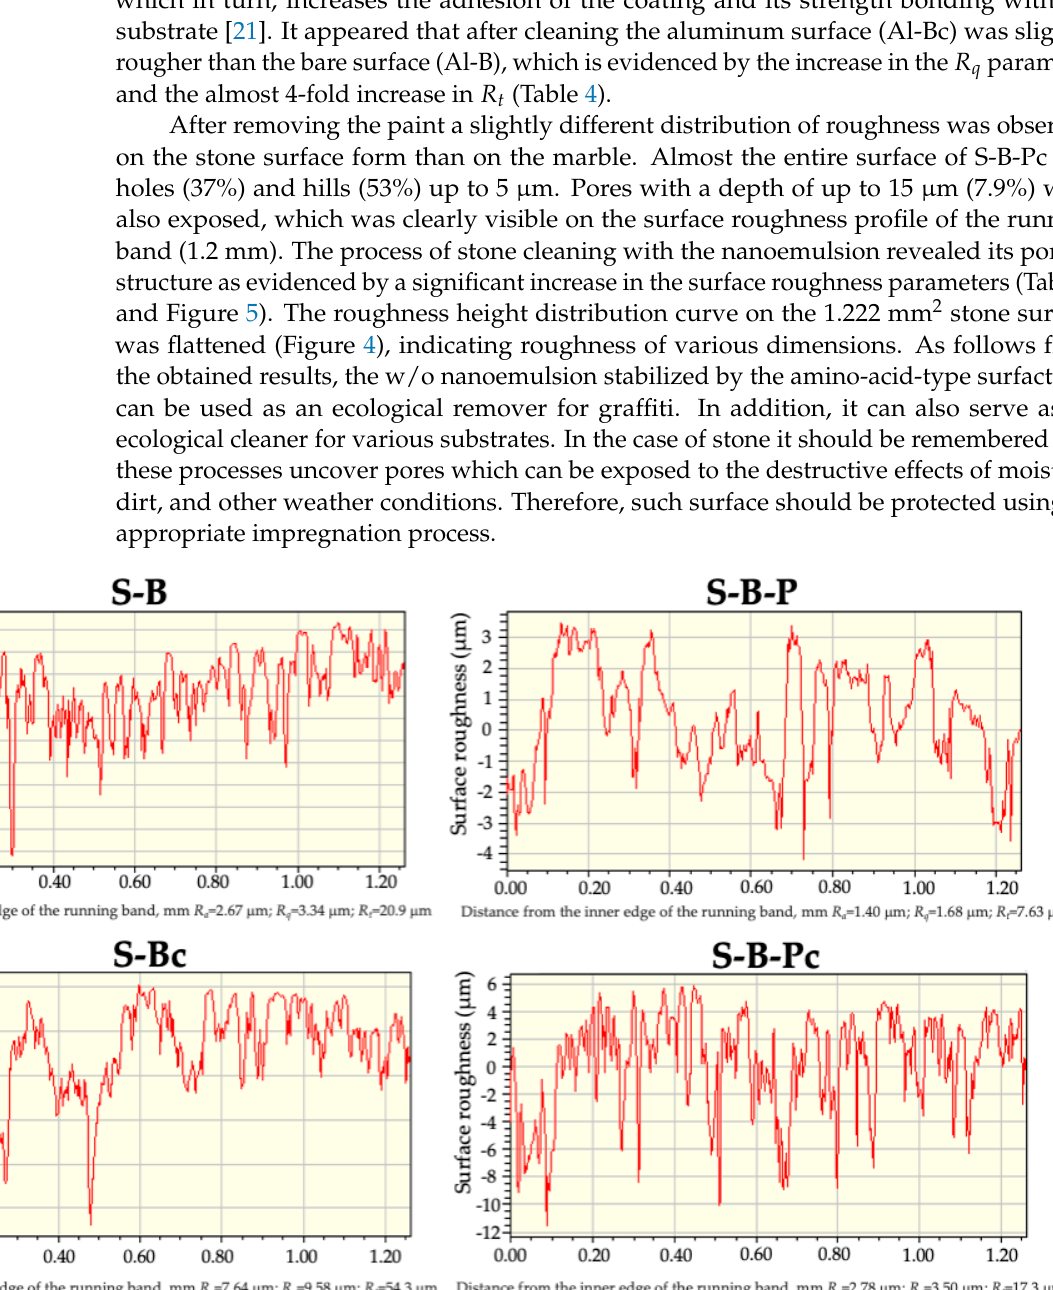
Figure 5. Surface roughness profiles of the running band on the bare stone (S-B), covered with the paint (S-B-P) after its removal and cleaning the bare surface (S-B-Pc). The figure also shows the values of the roughness parameters along the profile curve.